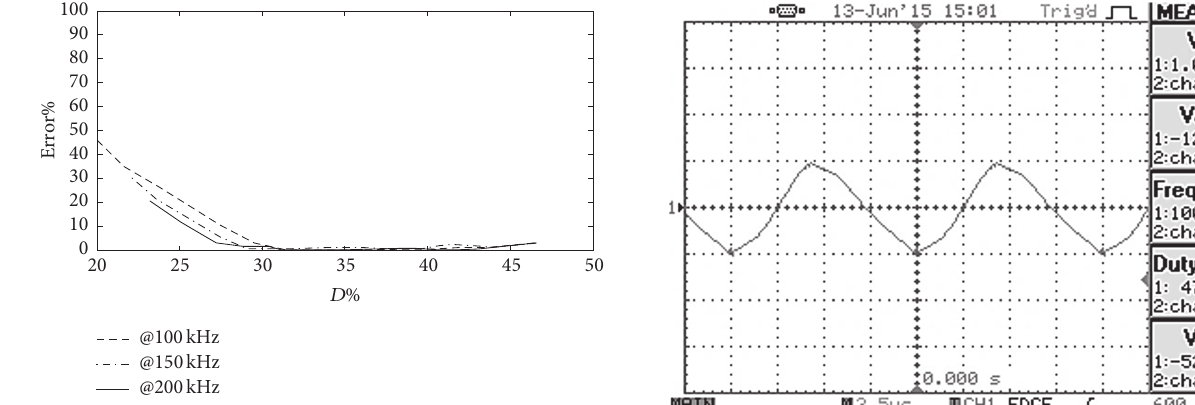
Figure 7: The %error in the experimental results with respect to the theory versus the duty cycle.